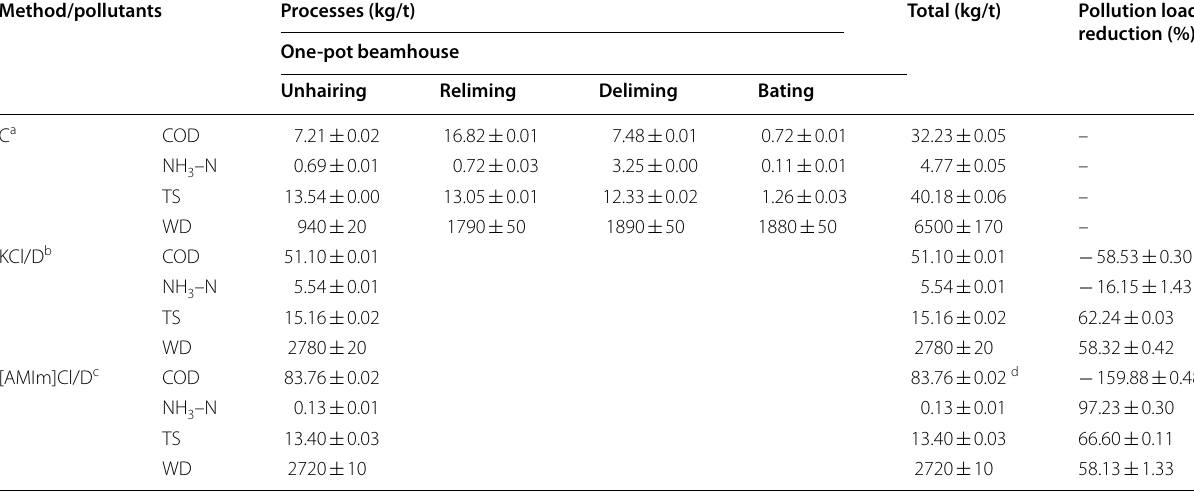
a Conventional process (C), wastewater was from unhairing/liming, reliming, deliming and bating b KCl/dispase process (KCl/D), wastewater was from one-pot beamhouse c [AMIm]Cl/dispase process ([AMIm]Cl/D), wastewater was from one-pot beamhouse d COD loads of [AMIm]Cl solution is 41.34 0.21 ±